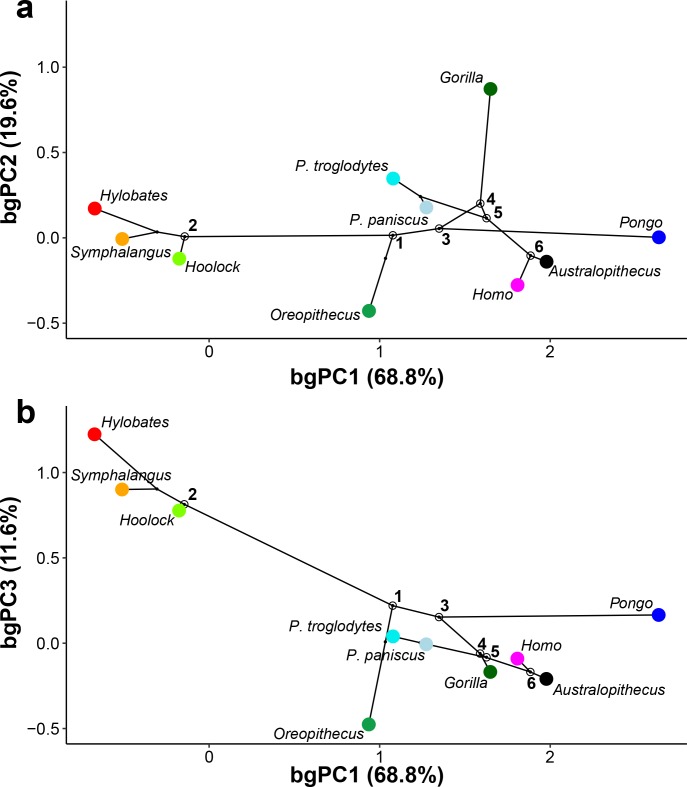
Reconstructed evolutionary history of the vestibular apparatus in the sample restricted to hominoids.The depicted phylomorphospaces are obtained by projecting the phylogeny displayed in Figure 13 on the bivariate plots between principal components: (a) bgPC2 vs. bgPC1 (see Figure 2a); (b) bgPC3 vs. bgPC1 (see Figure 2b). Color code: red, Hylobates lar; orange, Symphalangus syndactylus; light green, Hoolock hoolock; blue, Pongo pygmaeus; dark green, Gorilla gorilla; cyan, Pan troglodytes; purple, Pan paniscus; fuchsia, Homo sapiens; chartreuse, Oreopithecus bambolii; black, Australopithecus sp. Key ancestral morphologies reconstructed using maximum likelihood for the last common ancestor of various clades are depicted as follows: 1, crown hominoids (hylobatids and hominids); 2, crown hylobatids (gibbons and siamangs); 3, crown hominids (great apes and humans); 4, crown hominines (African great apes and humans); 5, Pan-Homo clade; 6 Australopithecus-Homo clade.